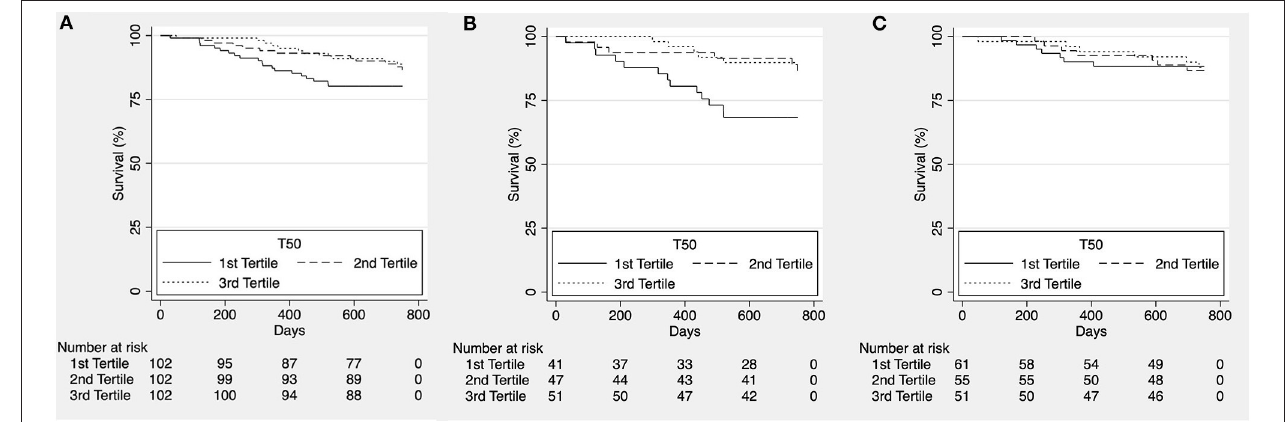
FIGURE 3 | Kaplan-Meier estimates for cardiovascular survival according to T 50 tertiles for the whole cohort [ (A) , p = 0.101], patients with ischemic heart failure with reduced ejection fraction [HFrEF; (B) , p = 0.011] and patients with non-ischemic HFrEF [ (C) , p = 0.978].